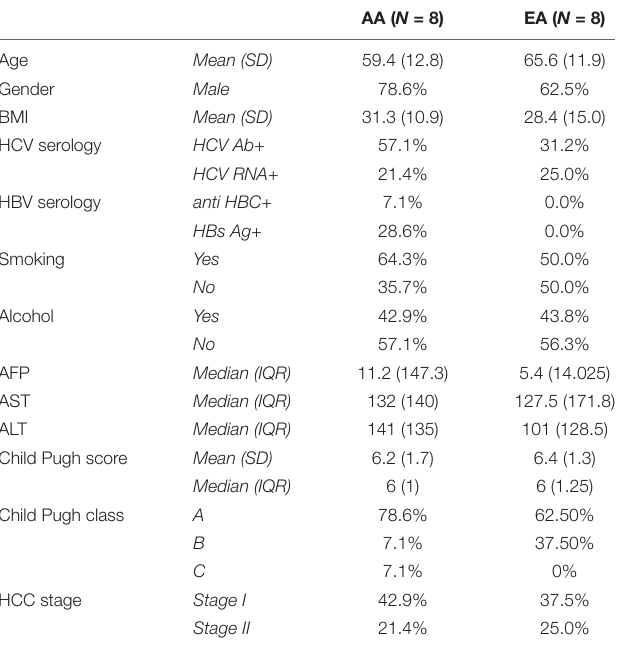
TABLE 1 | Characteristics of study